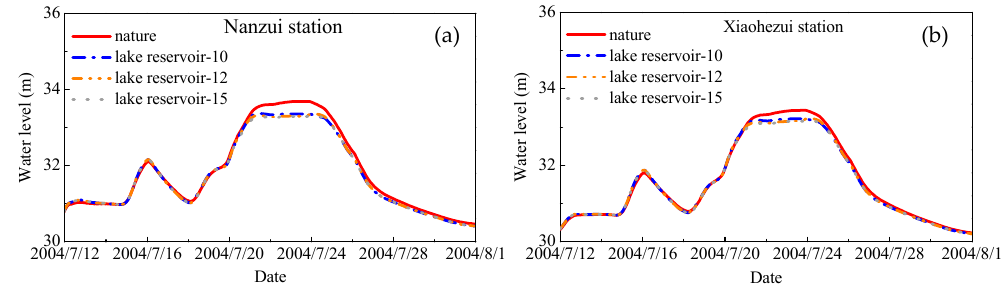
Figure 8. The time series of water elevation at two main flood control stations in the West Dongting Lake.